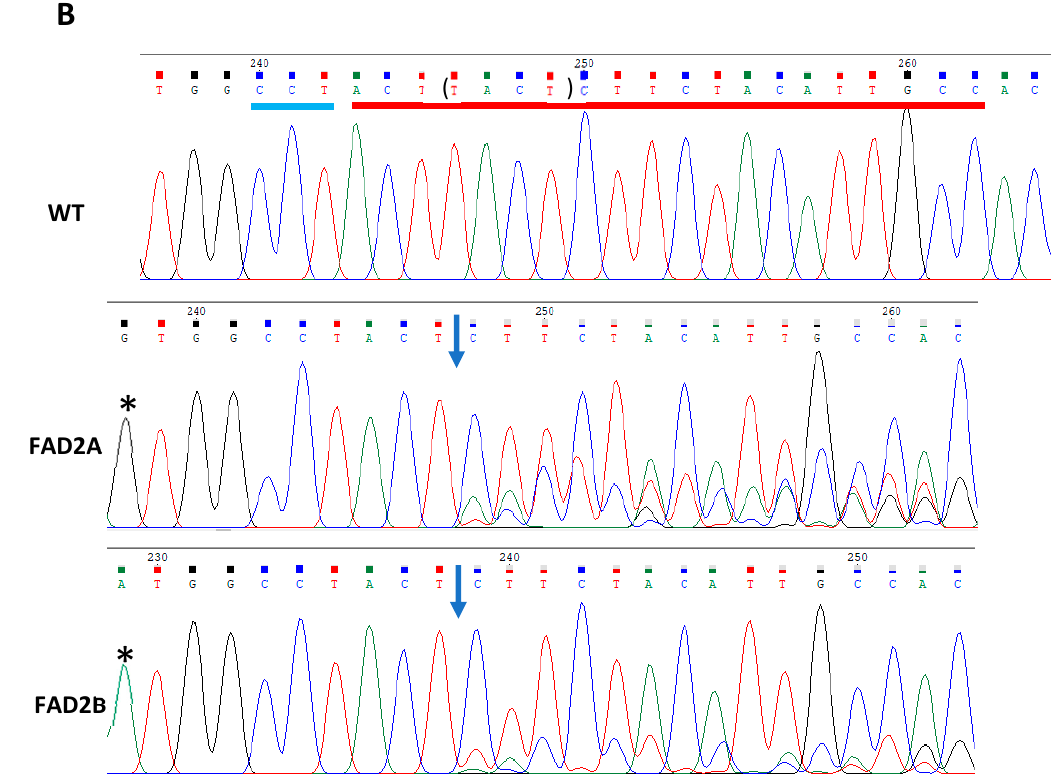
Figure 2. Mutagenesis induced in FAD2 genes by CRISPR/Cas9 medicated gene editing. ( A ). Two vectors, pDW3872 and pDW3877, induced different mutations with their editing efficiencies. * indicates an SNP between FAD2A and FAD2B . The target sequences are highlighted in red; insertion sequences in green; PAM in blue. ( B ). An example of chromatograms with 4 bases deletion in FAD2A and FAD2B . The arrow indicates the break site by nucleases and four bases (in parentheses of wild type sequence) deleted in FAD2 genes.